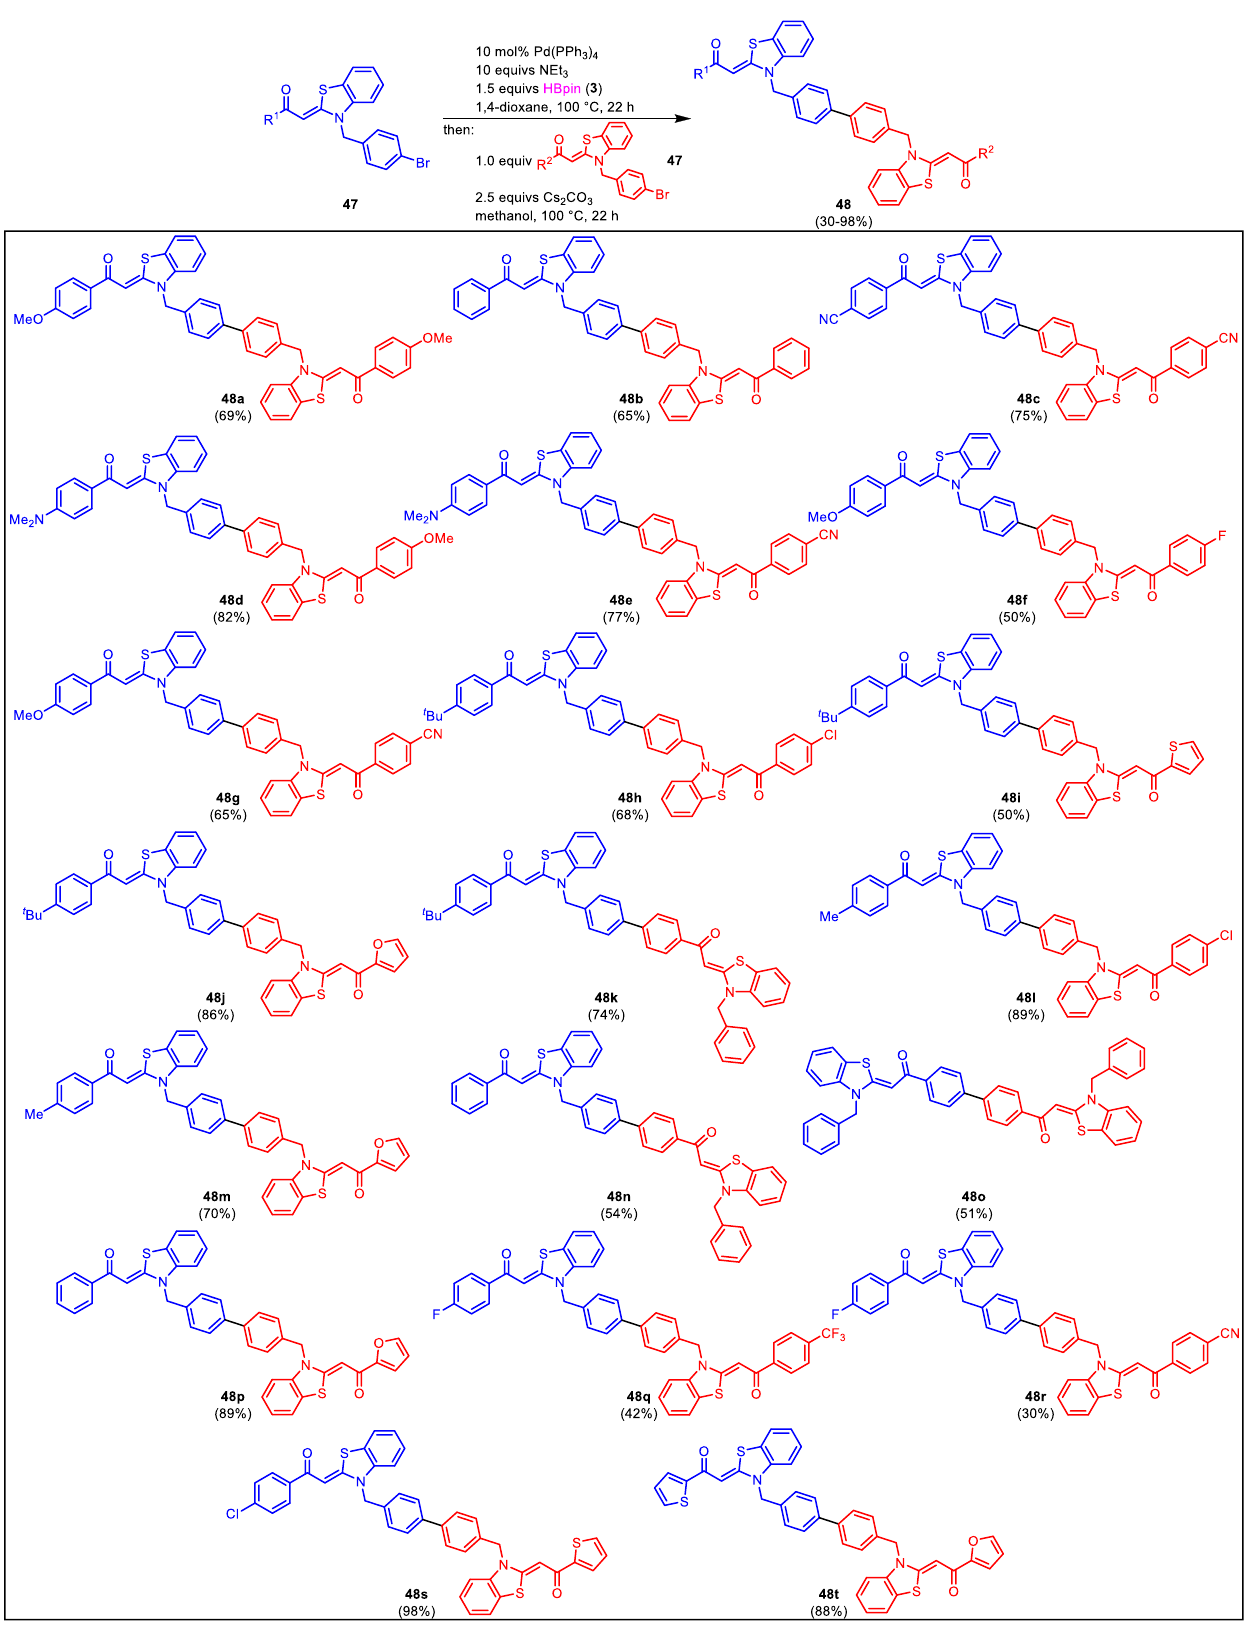
Figure 28. One-pot MBSC synthesis of bisaroyl- S , N -ketene acetals 48 by Biesen et al.